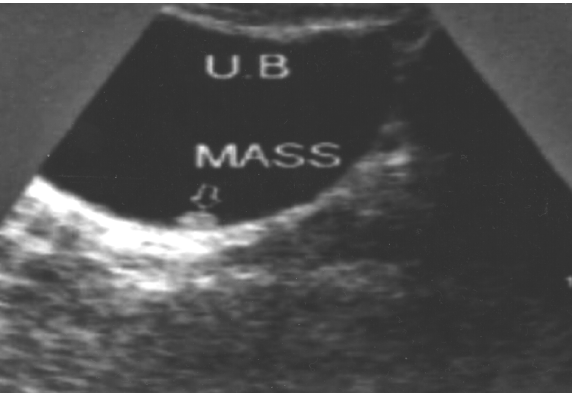
Figure 1 – A small tumor 0.9 x 0.6 cm in left posterolateral wall of urinary bladder.